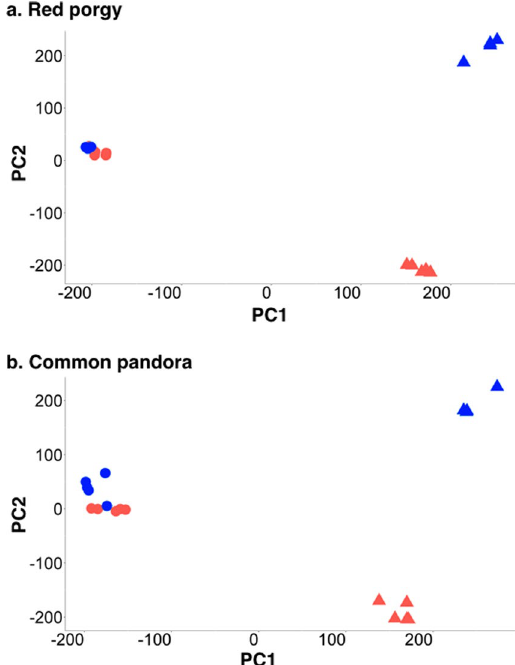
Figure 3. Principal component analysis of global expression profiles in two protogynous sparids. Principal component analysis of overall expression profiles of the gonad and brain samples of male and female individuals ( a ) Red porgy (PC1 = 49% variance and PC2 = 27% variance), ( b ) Common pandora (PC1 = 44% variance and PC2 = 22% variance). Blue = males, Red = females and Triangles = Gonads, Circles = Brains). All genes with non-zero total read count in the count matrix used for the PCA plot (a filtered